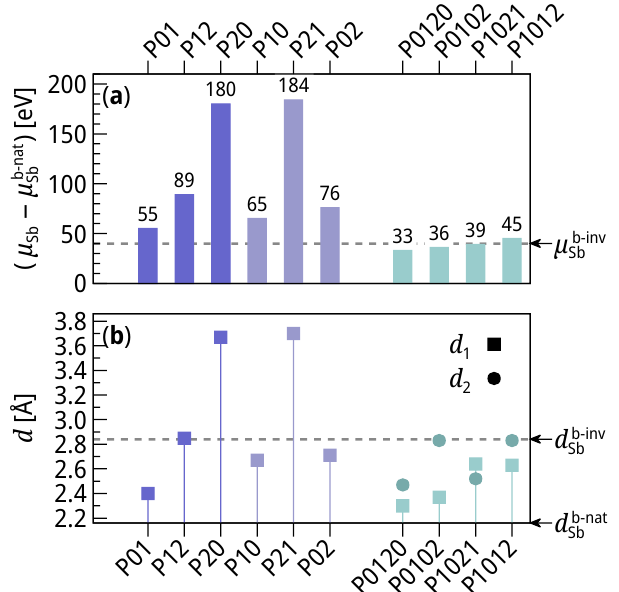
Figure 2. ( a ) Sb chemical potentials µ Sb in different structures. ( b ) Corresponding inter-layer distances d Sb of the Sb BLs. Blue: 1BL-Sb@BS, green: 2BL-Sb@BS. Squares: distance d 1 between BS and 1st BL; circles: distance d 2 between 1st BL and 2nd BL. The vertical lines under the points for the 1st BL highlight the correlation between d 1 and µ Sb